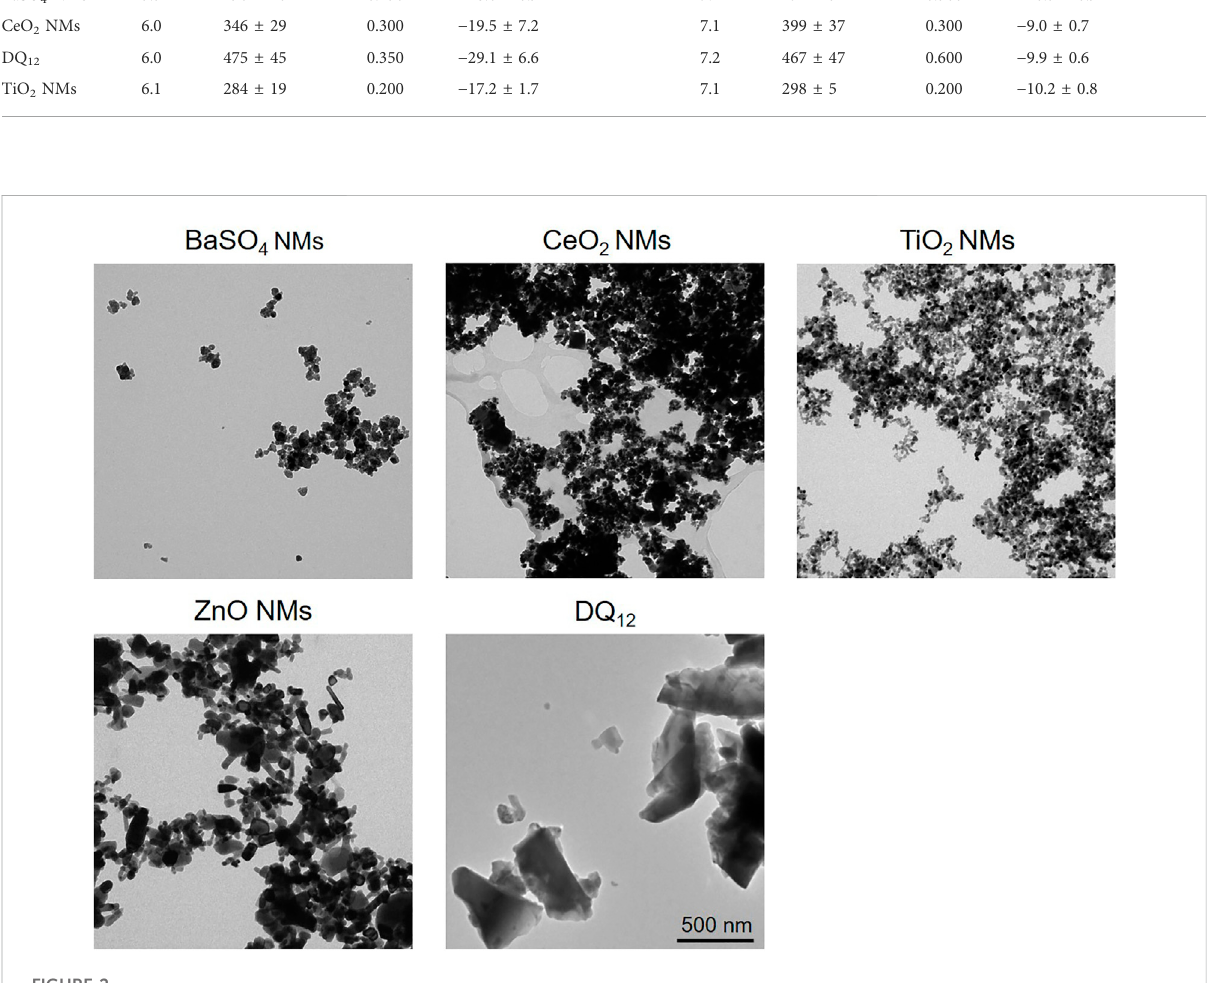
FIGURE 2 TEMimagesofBaSO 4 NMs(D mean =32 nm),CeO 2 NMs(D mean =14 nm),TiO 2 NMs(Dmean=25 nm),ZnONMs(D mean =41 nm),andcrystalline silica